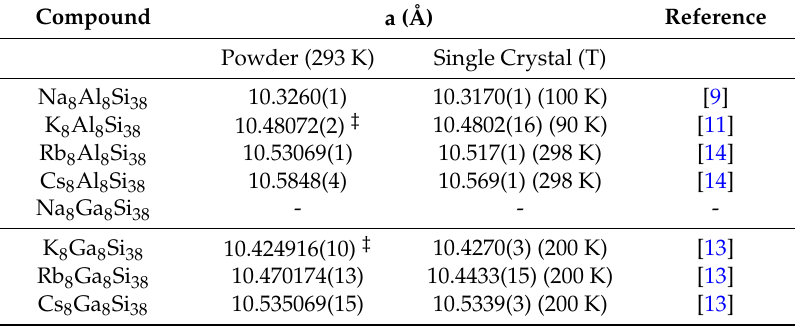
Table 1. Experimental Unit Cell Parameter of Type I Clathrate Phase A 8 E 8 Si 39 (A = Na, K, Rb, Cs; E = Al, Ga).